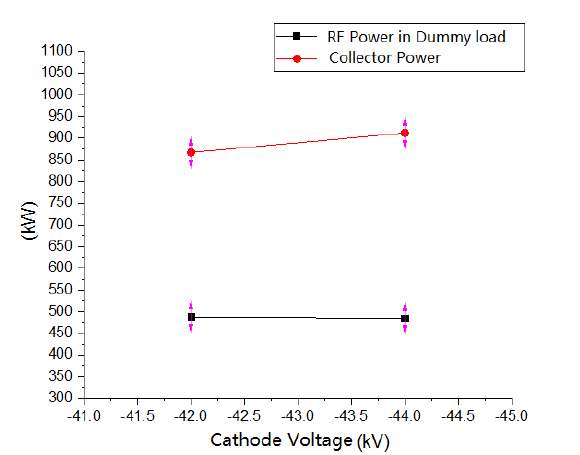
Fig. 11. Changes in the output power of the gyrotron when the magnetic field current, filament primary voltage, filament primary current, and beam voltage are 50.55A, 39.7V, 34.7A, and 65kV,